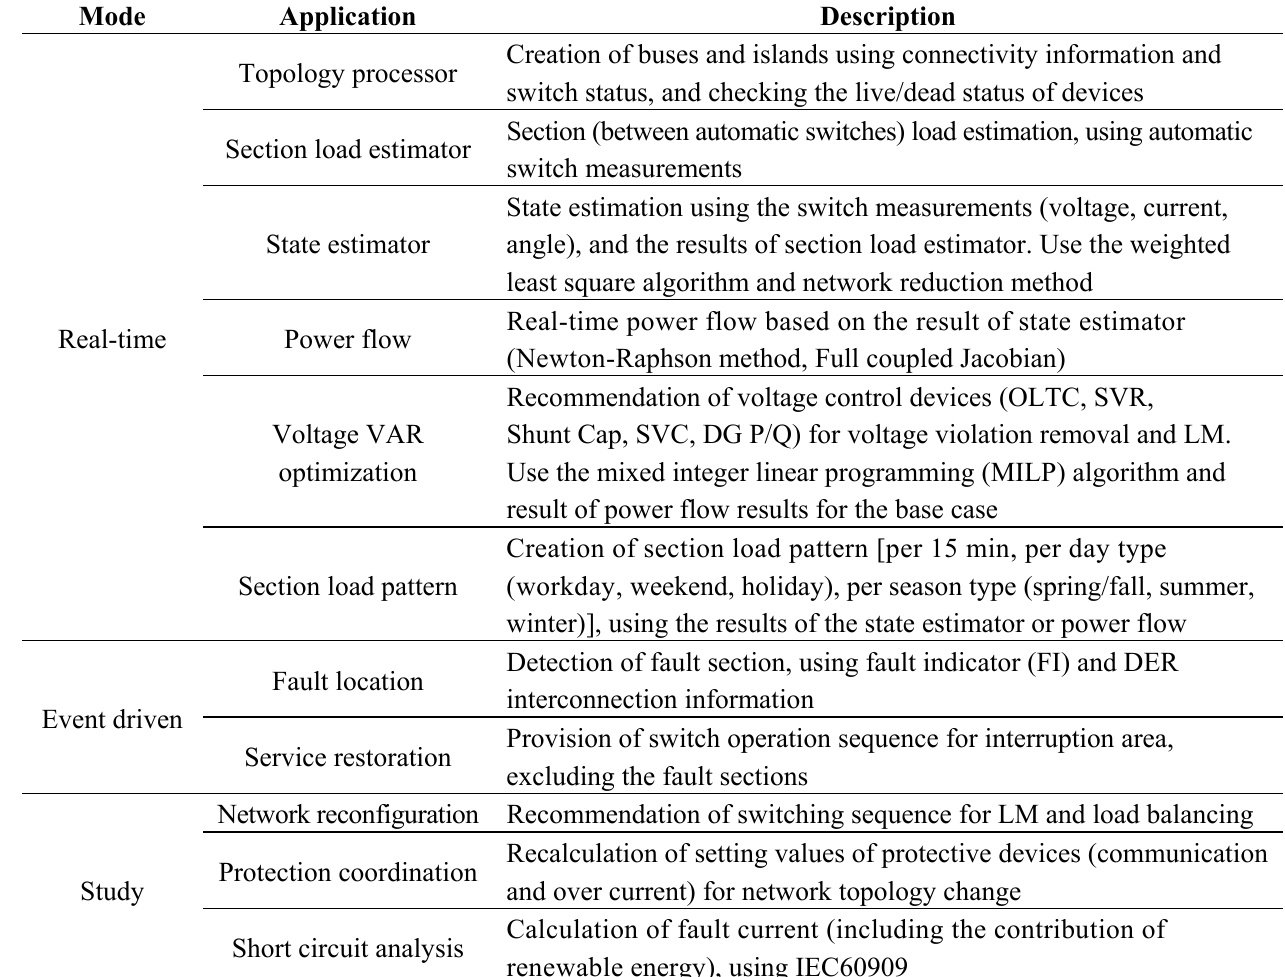
Table 3. Development of KSDMS application